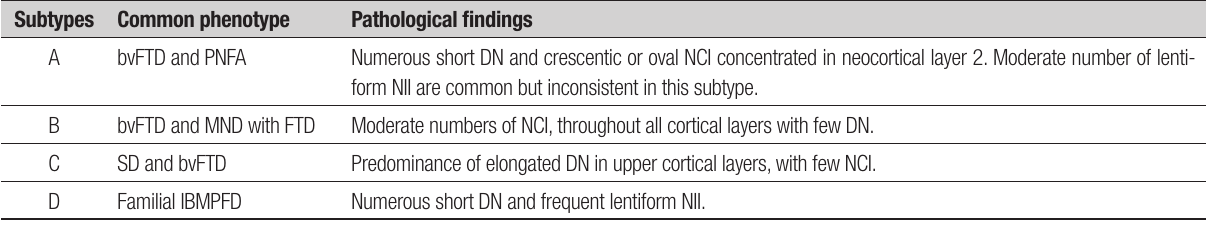
Table 2. Harmonized classification for FTLD-TDP pathology (Adapted from Mackenzie et al., 2011) 74 . Subtypes Common